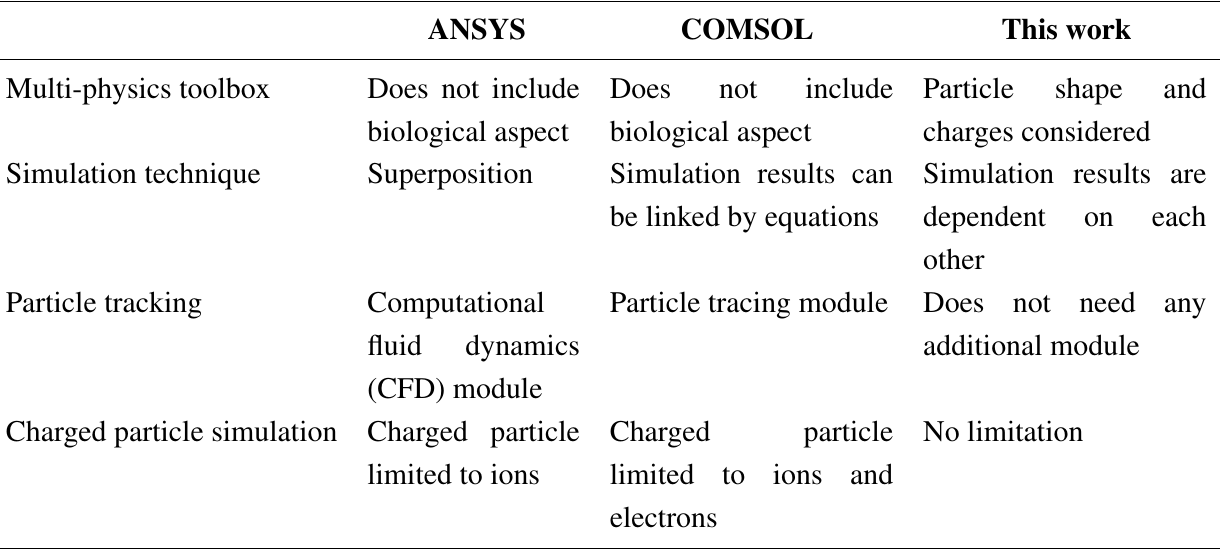
Table 1. Comparaison of different modeling